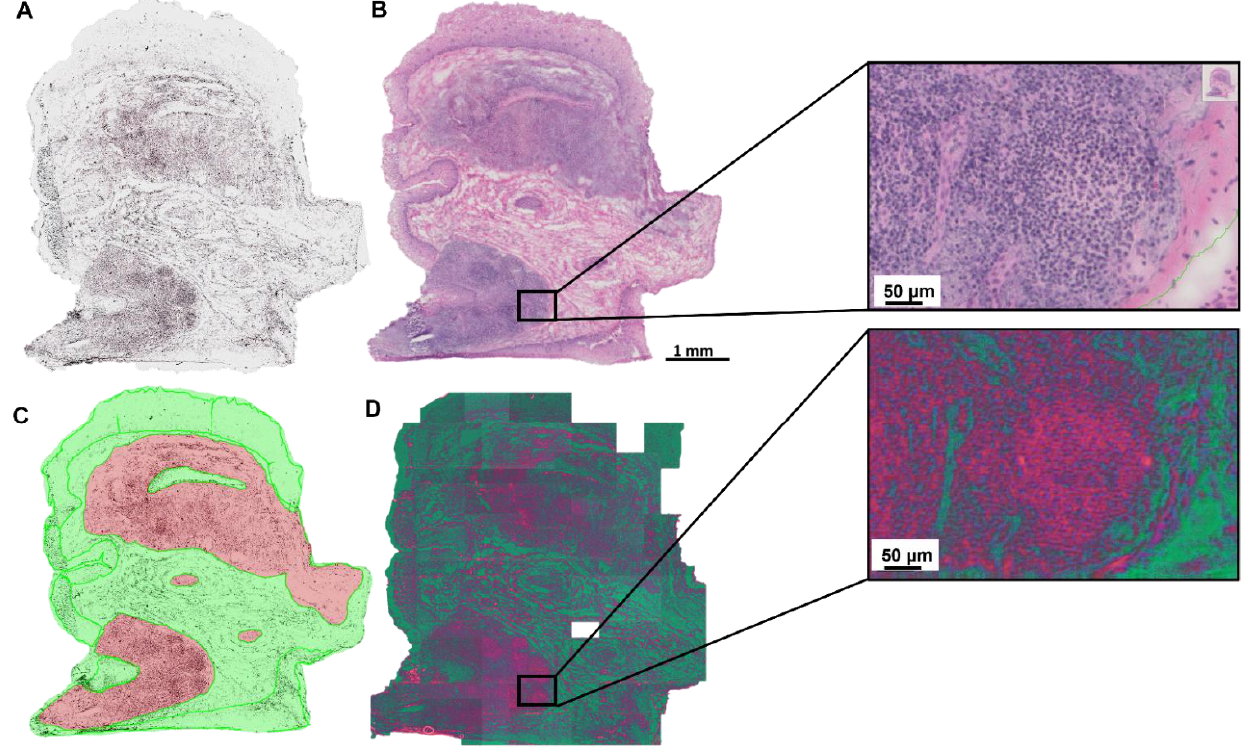
Figure 2. False color image representing the results of the Umap dimensionality reduction. ( A ) unstained tissue section. ( B ) H&E stained tissue section. ( C ) Manual histopathological annotations on H&E-stained tissue section. ( D ) False color image to visualize the results of the dimensionality re- duction algorithm. Red feature: cytoplasm, green feature: background, collagen and the extracellular matrix, blue feature: nuclei. The empty white tile in ( D ) was removed from the dataset due to a lack of tissue or poor matching between HSI and microscopic imaging .